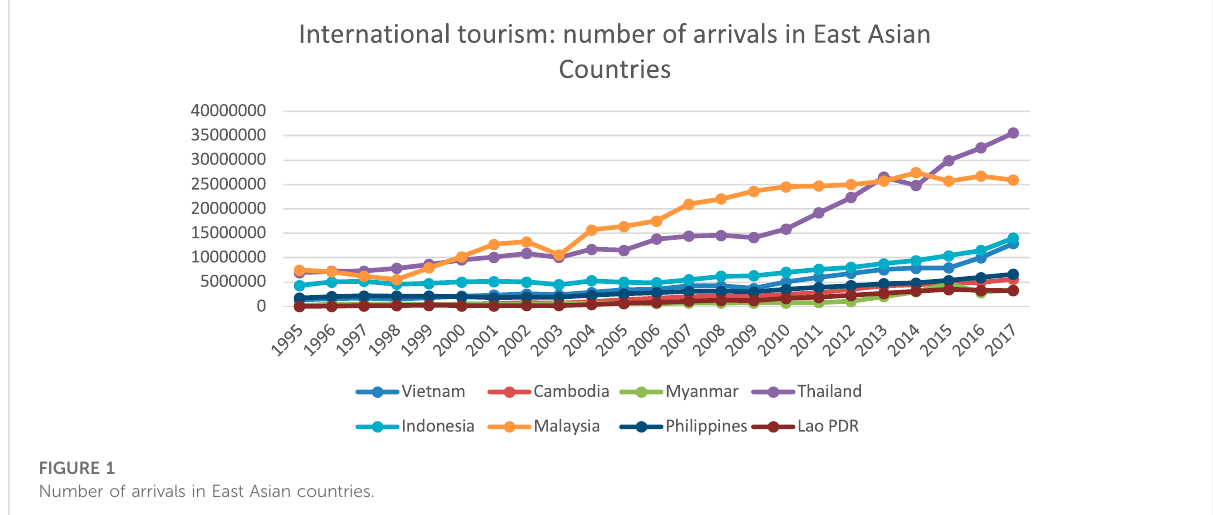
FIGURE 1 Number of arrivals in East Asian